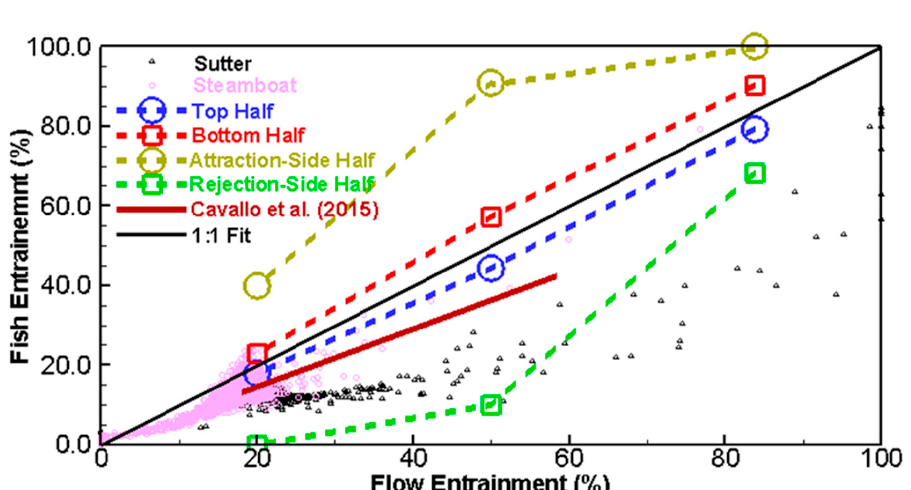
Figure 8. Computed fish entrainment rate versus flow diversion rate for the 90-degree juncture stud- ied by Ramamurthy et al. [3]. Field data at the Sutter and Steamboat junctures of the Sacramento [32] and the linear regression developed by [31] based on the fish telemetry data at seven flow junctions of the Sacramento River are also plotted.